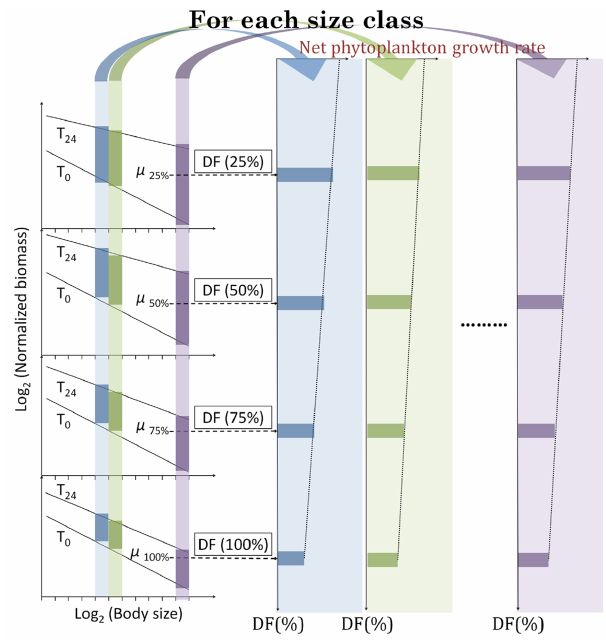
Fig. 2. Schematic illustrating how the size-specific growth rate and grazing mortality for each size class were calculated. Left panel shows the relationship between phytoplankton biomass versus size at T 0 and T 24 (black lines) for each dilution factor. Dilution factor (DF) represents the percentage of unfiltered seawater. Right panel illustrates the regression analysis of realized phytoplankton growth rate ( x axis) versus the corresponding dilution factors ( y axis) for each size class. Colours indicate different size classes. By compar- ing the phytoplankton biomass at T 0 and T 24 under different dilu- tion factors for each size class, one can estimate size-specific growth rate and grazing mortality using the regression approach commonly employed in dilution experiments for each size